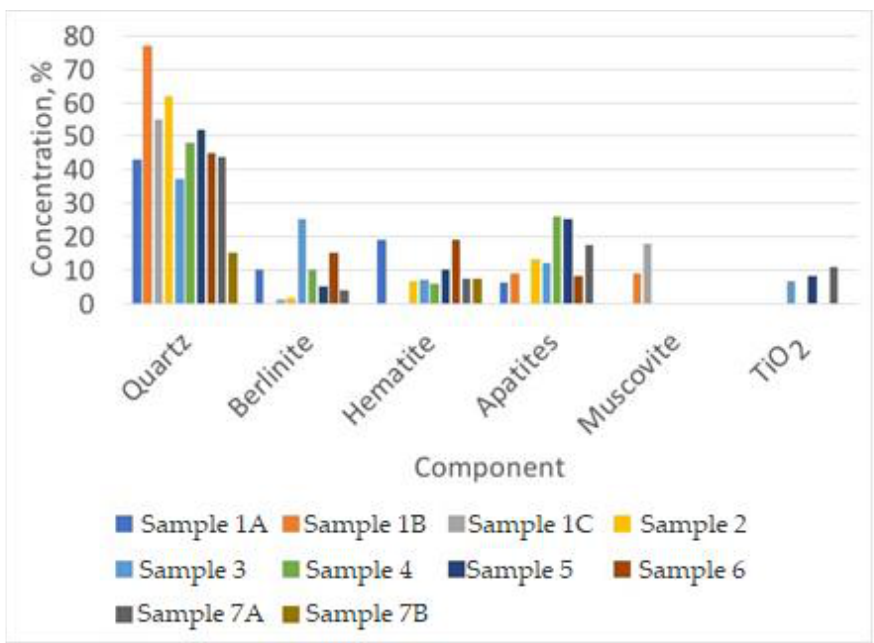
Figure 2. XRD registrations for the investigated pottery.